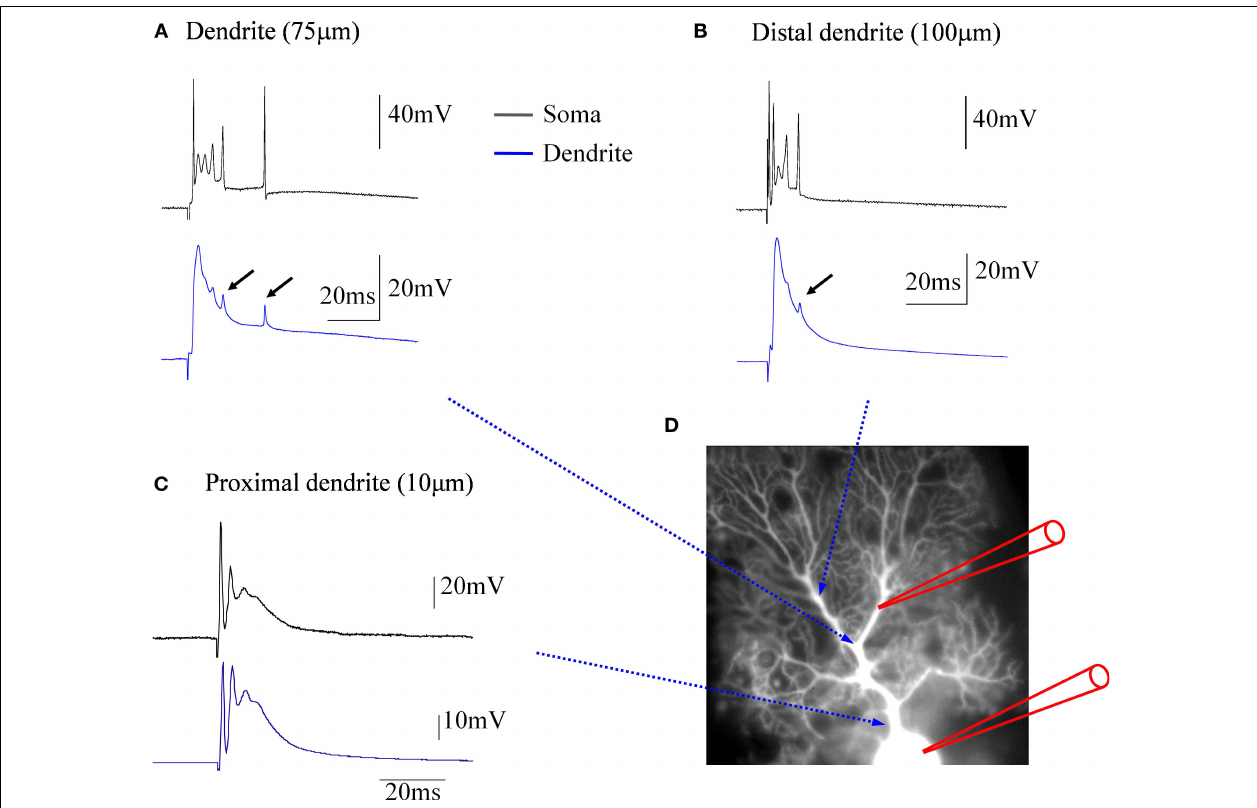
FIGURE 1 | Climbing fi ber responses monitored by simultaneous double patch-clamp recordings from the soma and dendrites of cerebellar Purkinje cells. (A) Paired recordings from the soma (black trace) and the dendrite (blue trace). The dendritic patch electrode was located at about 75 µm distance from the soma. (B) In this recording, which was obtained from a different Purkinje cell, a more distal location (ca. 100 µm) was selected for the dendritic patch electrode. Small arrows in (A) and (B) point towards small, delayed spikelets seen in the dendritic recordings, that likely refl ect sodium action potentials generated in the axon (see corresponding, but larger spikes in the somatic recordings), which passively spread into the dendrite. (C) At a far more proximal location (ca. 10 µm), the dendritic recording resembles the complex spike recorded in the soma, but already at this distance an attenuation of the initial, fast sodium spike can be seen. (D) Recording confi guration of the